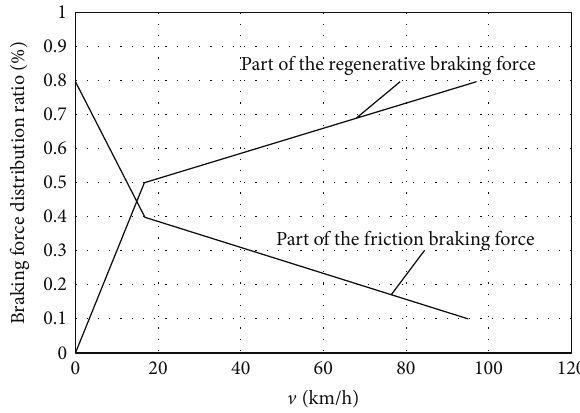
Figure 2: The distribution of the braking force in ADVISOR [22].